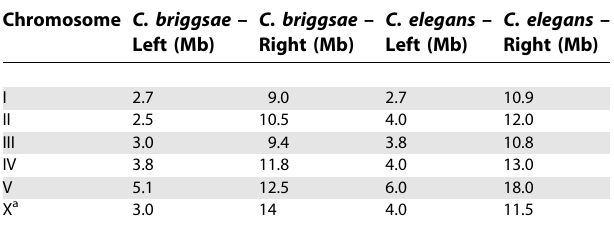
Figure S1. Distribution of Features across C. briggsae Chromosomes Graphs of each feature for each chromosome corresponding to the data provided in Dataset S3. Found at doi:10.1371/journal.pbio.0050167.sg001 (140 KB PDF). Figure S2. Distribution of Features across C. elegans Chromosomes Graphs of each feature for each chromosome corresponding to the data provided in Dataset S4. Found at doi:10.1371/journal.pbio.0050167.sg002 (151 KB PDF). Figure S3. Ortholog Positions Graphical representations of the positions of 1:1 orthologs in both C. elegans and C. briggsae . Graphical representations are provided for all on-chromosome relationships. Found at doi:10.1371/journal.pbio.0050167.sg003 (150 KB PDF). Figure S4. Recombination Data Plot of the physical versus genetic map positions for C. elegans . Found at doi:10.1371/journal.pbio.0050167.sg004 (243 KB